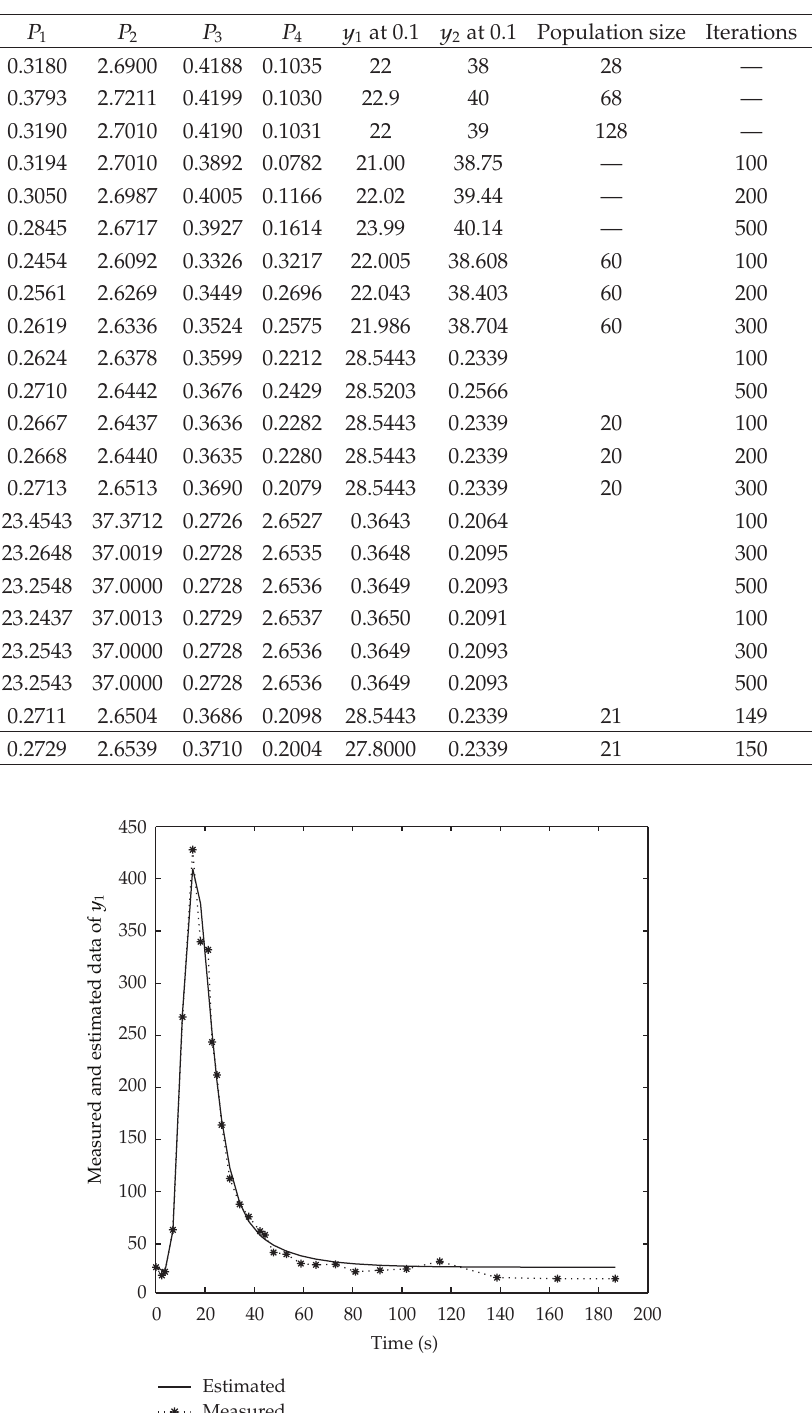
Table 2: Results of Case 1 (cid:3) An enzyme e ff usion problem (cid:4) .